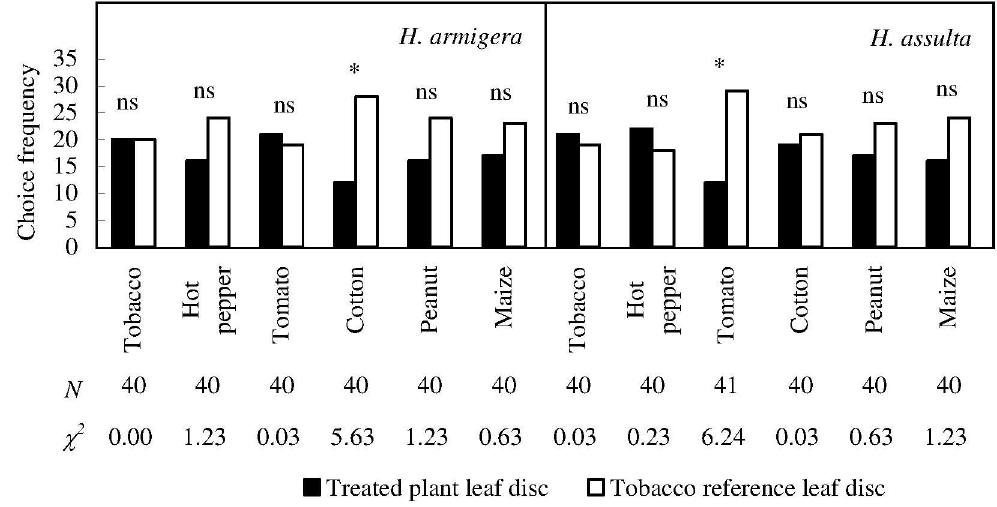
Fig 6. Choice responses of H . armigera and H . assulta larvae under the conditions of each plant leaf disc paired with tobacco leaf disc. “ * ” indicates significantdifference within group at P = 0.05 level, and “ns” indicates no significantdifference within group, accordingto chi-squaretest. The values of “ N ” and “ χ 2 ” beneathrespective bars indicate numberof test insects and statistical χ 2 values,